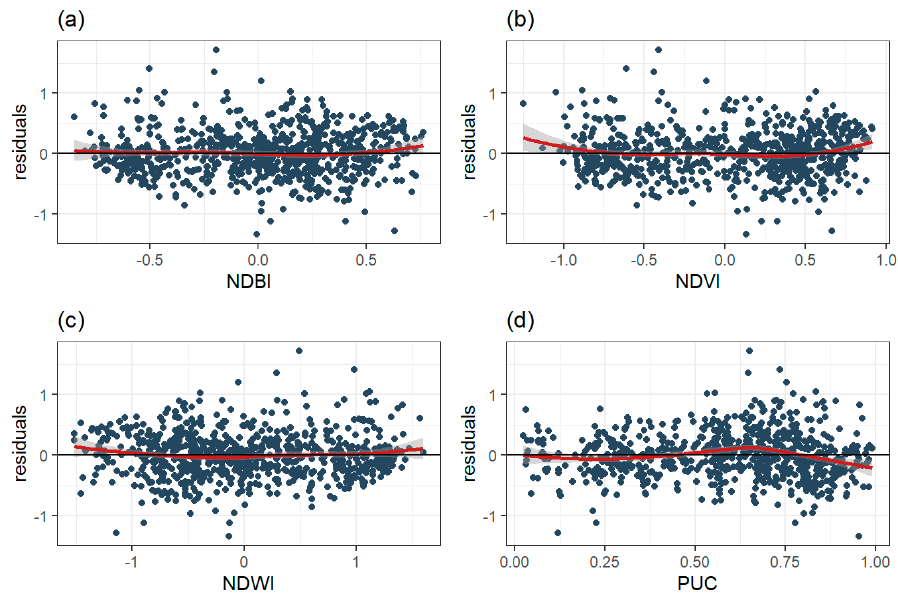
Figure 12. Performance of the linearity of the model. Graphs of the regression analysis residuals vs fitted lines. ( a ) NDBI vs residuals. ( b ) NDVI vs residuals. ( c ) NDWI vs residuals. ( d ) PUC vs resid- vs. fitted lines. ( a ) NDBI vs. residuals. ( b ) NDVI vs. residuals. ( c ) NDWI vs. residuals. ( d ) PUC vs. uals. residuals.